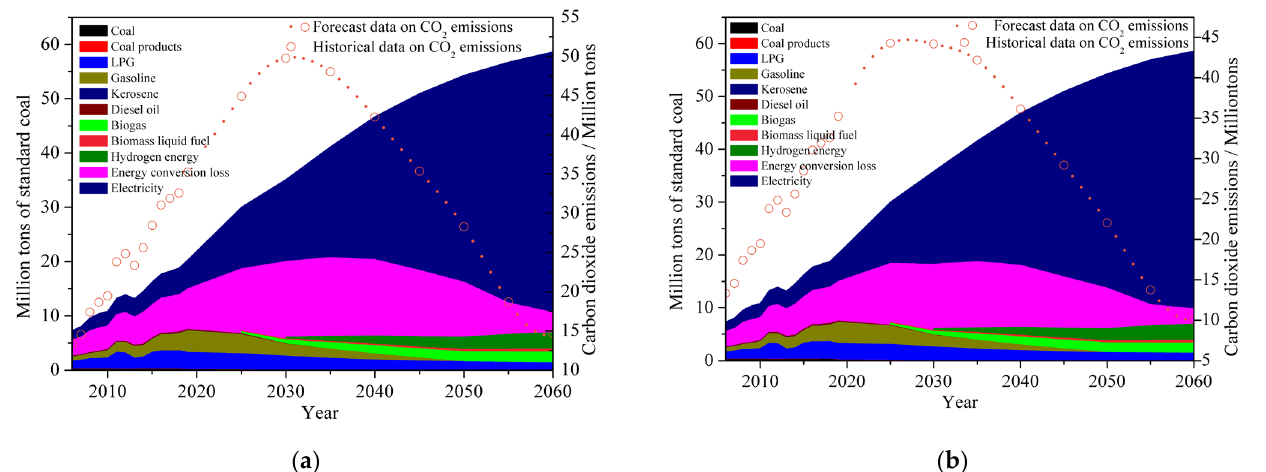
Figure 8. ( a ) Energy consumption and total carbon emissions forecast under the base scenario. ( b ) Forecast under the radical model.